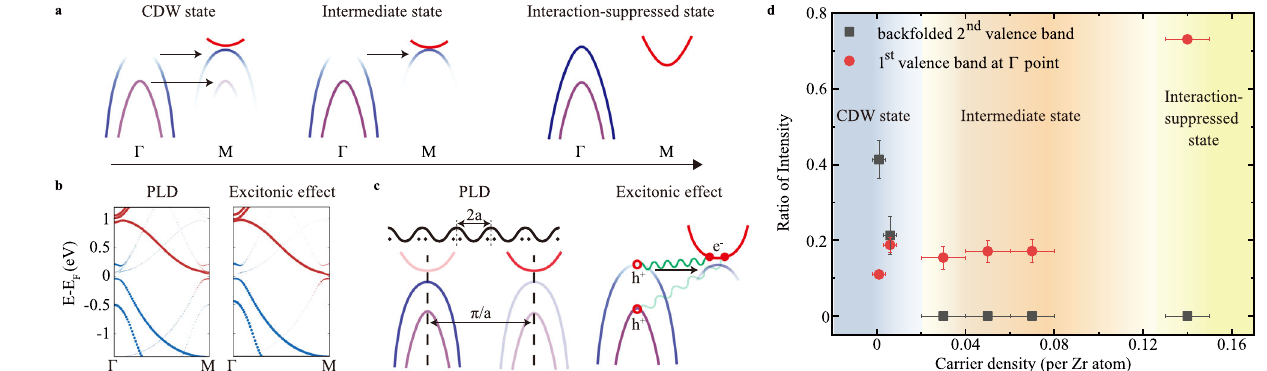
Fig. 4 | The origin of CDW phase in monolayer 1T-ZrTe 2 . a The schematic band diagram of the formation of the CDW state. b The calculated band structure along the Γ -M direction for CDW driven by PLD and excitonic effect, respectively. c The schematic diagram of PLD and excitonic effect, respectively. d The evolution of